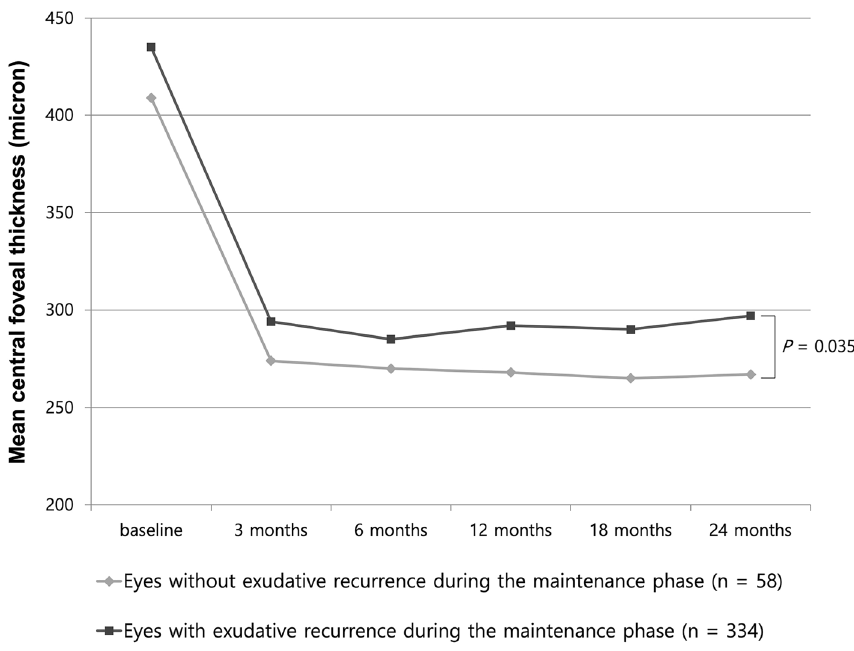
Figure 2. Central foveal thickness of the groups with and without exudative recurrence during the 24-month follow-up. The central foveal thickness of both the groups was maintained after the initial three loading injections during the 24 months. The central foveal thickness of the eyes without exudative recurrence was significantly lesser than that of the eyes with recurrence after 24 months ( P =